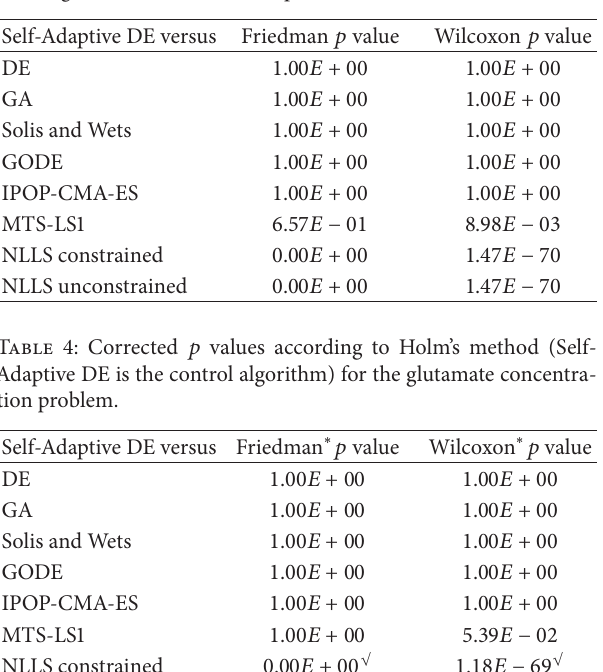
Table 3: Raw 𝑝 values (Self-Adaptive DE is the control algorithm) for the glutamate concentration problem.